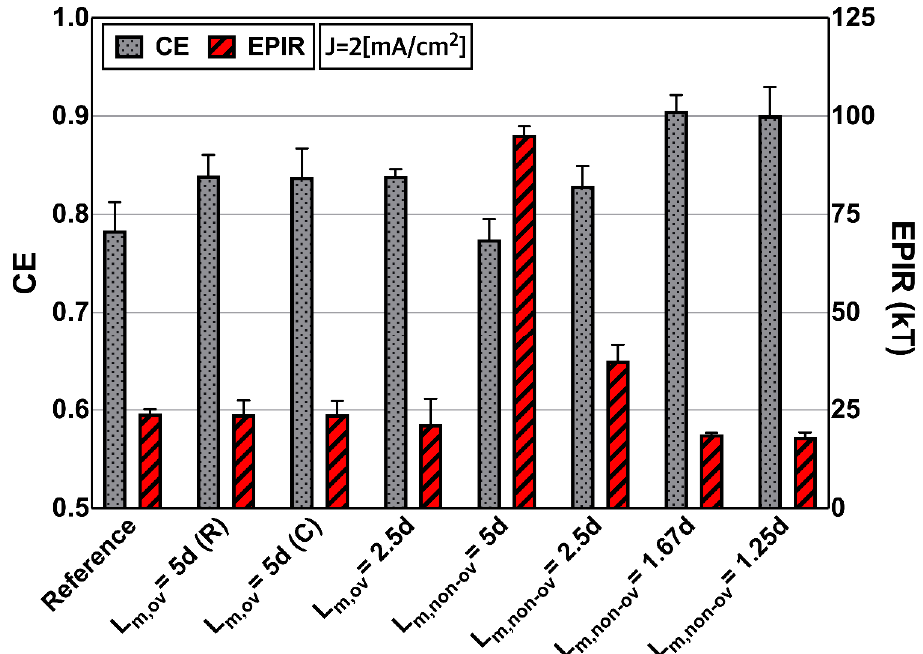
Figure 6. Desalination performances afforded by partially masked ion-exchange membranes. The CE and EPIR values were calculated from desalination experiments performed at constant current density (J = 2 mA/cm 2 ). The CE values of L m,ov membranes were enhanced to a greater extent than the CE values of the other membranes (L m,non-ov , reference). In terms of the EPIR values (expressed as functions of CE and voltage (V eff )), the values for the non-overlapped membranes were almost twofold greater than the values for the L m,ov and reference types, principally because the EPIR values are dominated by voltage increments rather than the CE values.